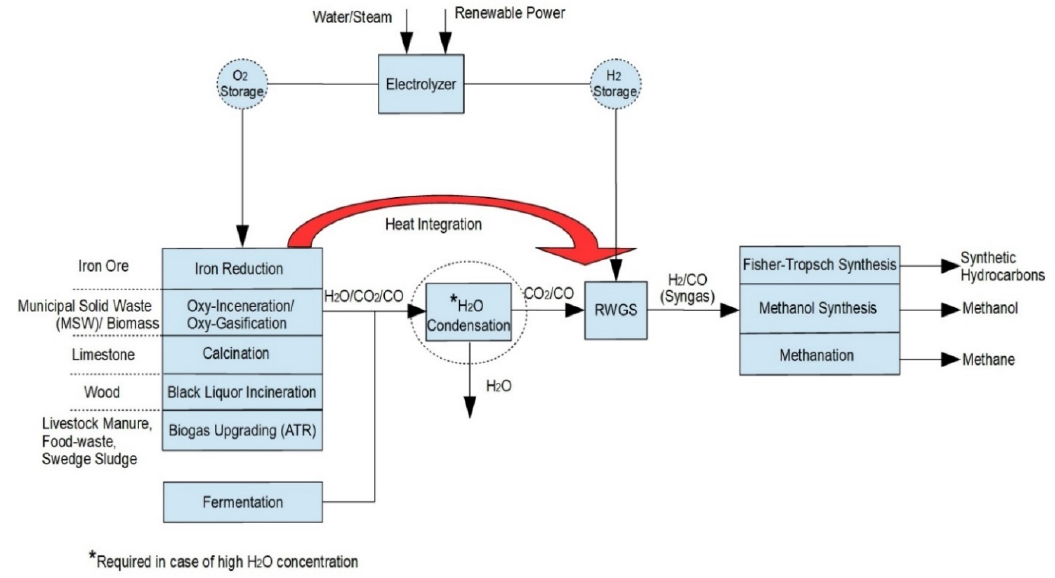
Figure 6. Conceptual framework of process integration of Reverse Water Gas Shift Reaction (RWGS).